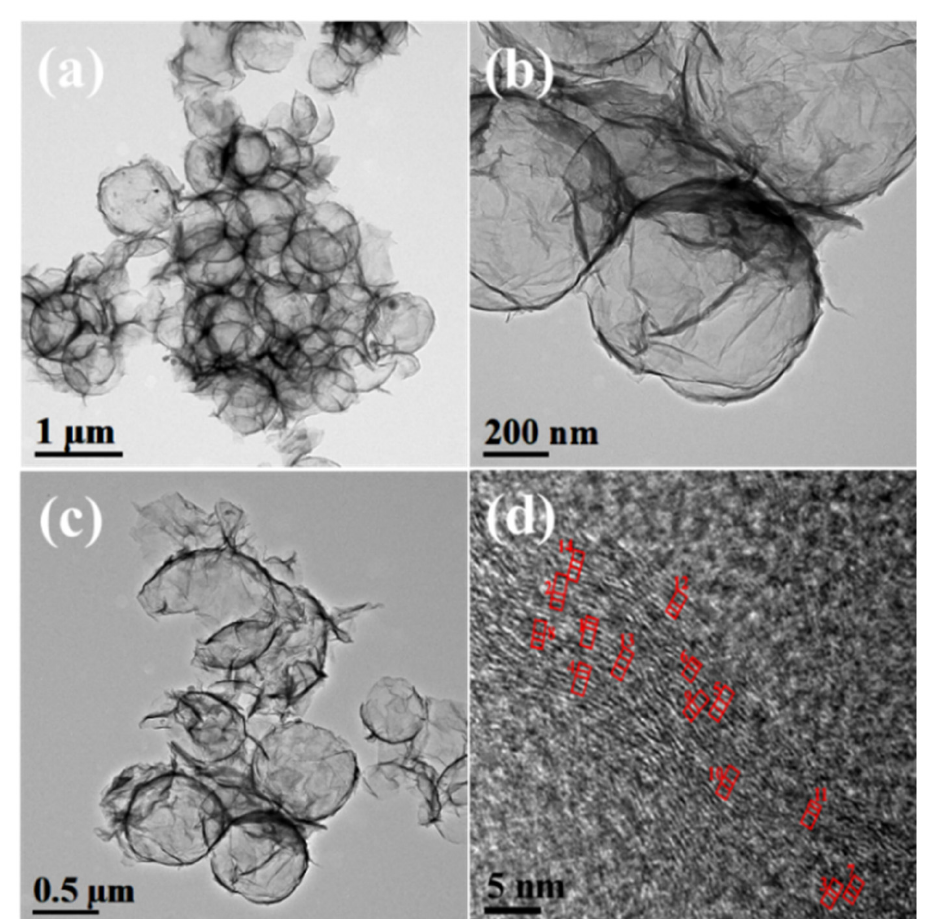
Figure 4. TEM images of ( a – c ) MRGO-HS. ( d ) HRTEM image of MRGO-HS with the multi-layer structure indicated by the red line.